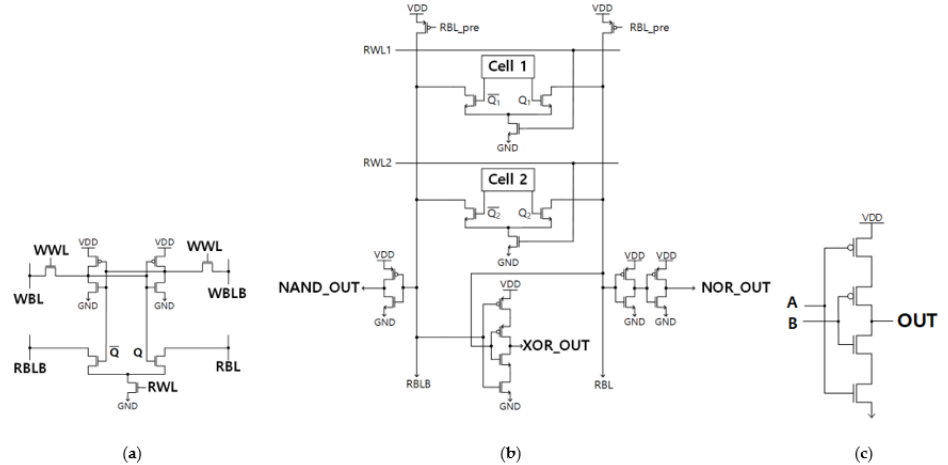
Figure 1. ( a ) 8 + T Differential SRAM Cell [12]; ( b ) 8 + T Differential SRAM ‐ based IMC circuit [11]; ( c ) the schematic of 2 ‐ input Muller C ‐